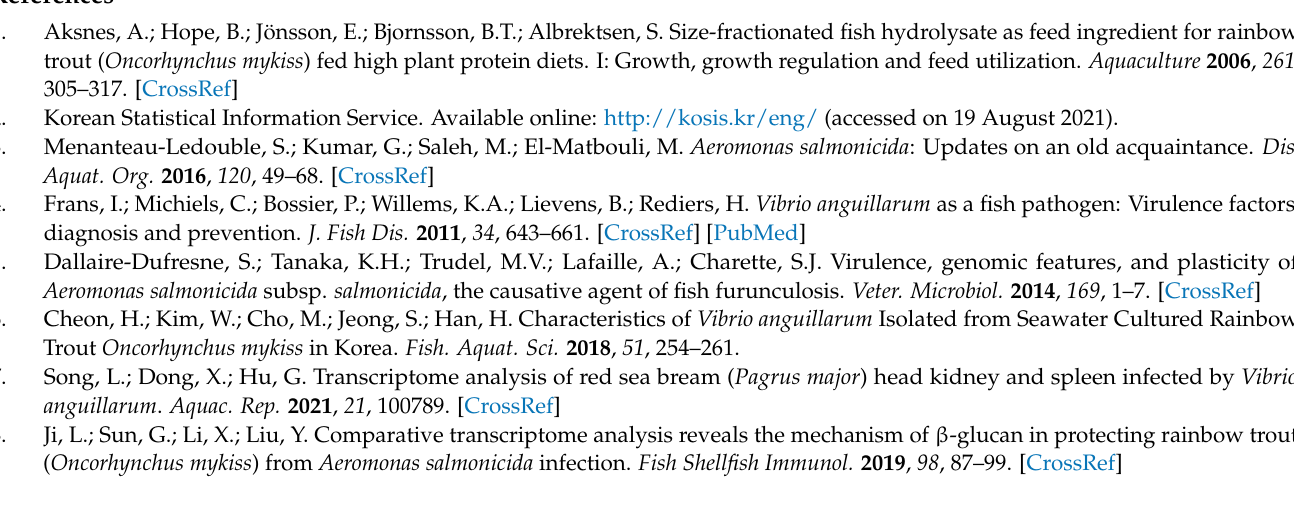
for the sequencing data on nine samples. Table S3: Statistics of clean reads mapped onto reference genome. Table S4: Comparative analysis of DEG between PBS and AV. Table S5: Top 10 nodes for PPI network centrality analysis of immune-related